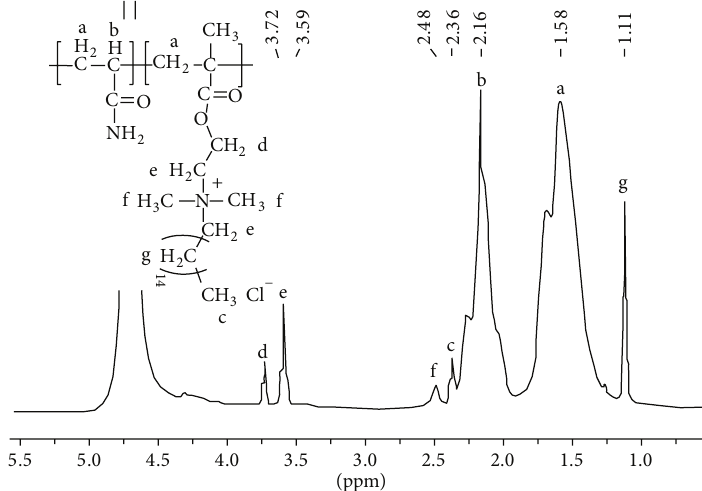
Figure 5: 1 HNMR spectra of copolymer 0.75DM12.8.